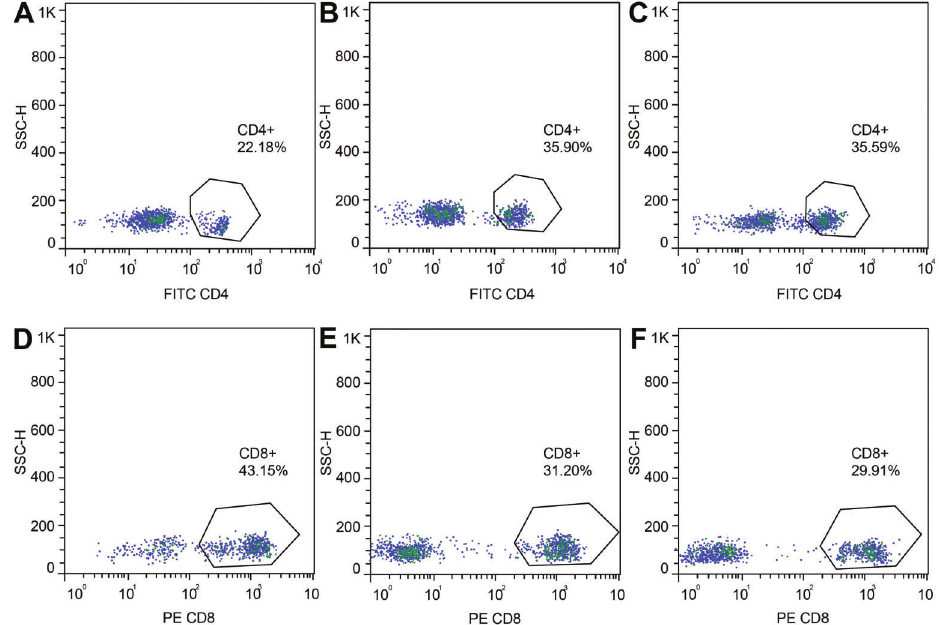
Figure 5. Percentages of CD4 + lymphocytes in the spinal tuberculosis experimental group ( A ), in the sham-operated group ( B) , and in the blank group ( C ). Percentages of CD8 + lymphocytes in the experimental ( D) , sham-operated ( E) , and blank groups ( F ).